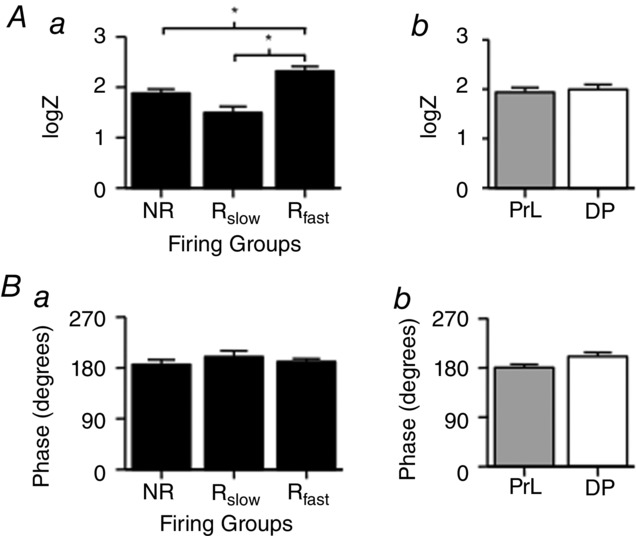
Phase coherence and phase preference of mPFC cell firing during Cb–KA-evoked network oscillationsA, barplots of the phase-coherence logZ values grouped with respect to the rhythmicity profile cells exhibited (a; NR, Rslow or Rfast) or the region they were recorded from (b; PrL or DP). Two-way ANOVA revealed a significant difference between cells with different rhythmicity profiles (F(2,88) = 9.550, P < 0.001, two-way ANOVA, Tukey's test, nNR = 42, nslow = 14, nfast = 37). The difference between PrL and DP cells was not significant (F(1.88) = 0.03, P > 0.05, two-way ANOVA, nPrL = 50, nDP = 43). B, the same analysis as in A was performed on the phase values. Barplots show that mPFC cells with different rhythmicity profiles (a; P = 0.727, Harrison–Kanji test, nNR = 42, nslow = 14, nfast = 37) or recorded from different regions (b; P = 0.281, Harrison–Kanji test, nPrL = 50, nDP = 43) fired spikes around the trough or the rising phase of the field cycle.